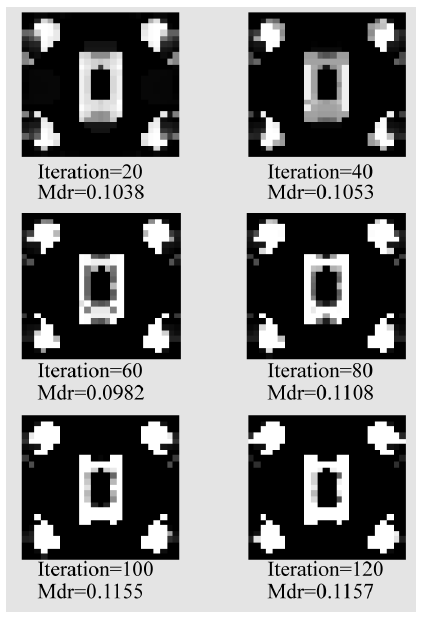
Fig. 23. Optimal distribution of damping material at different iteration numbers, vf =